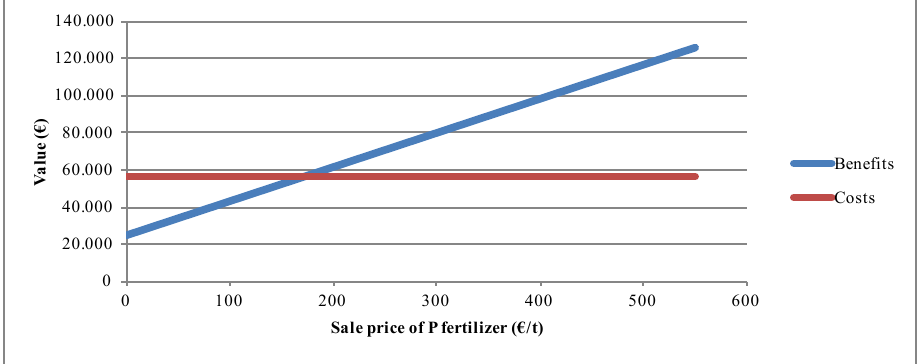
Figure 5. Market-based cost-benefit analysis for the employment of a SCM in a 120,000 IE